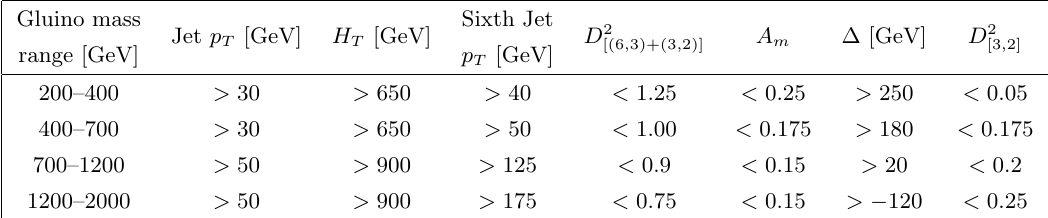
Table 2. The list of selection criteria with the direction of the cuts and the mass ranges analyzed by the CMS search